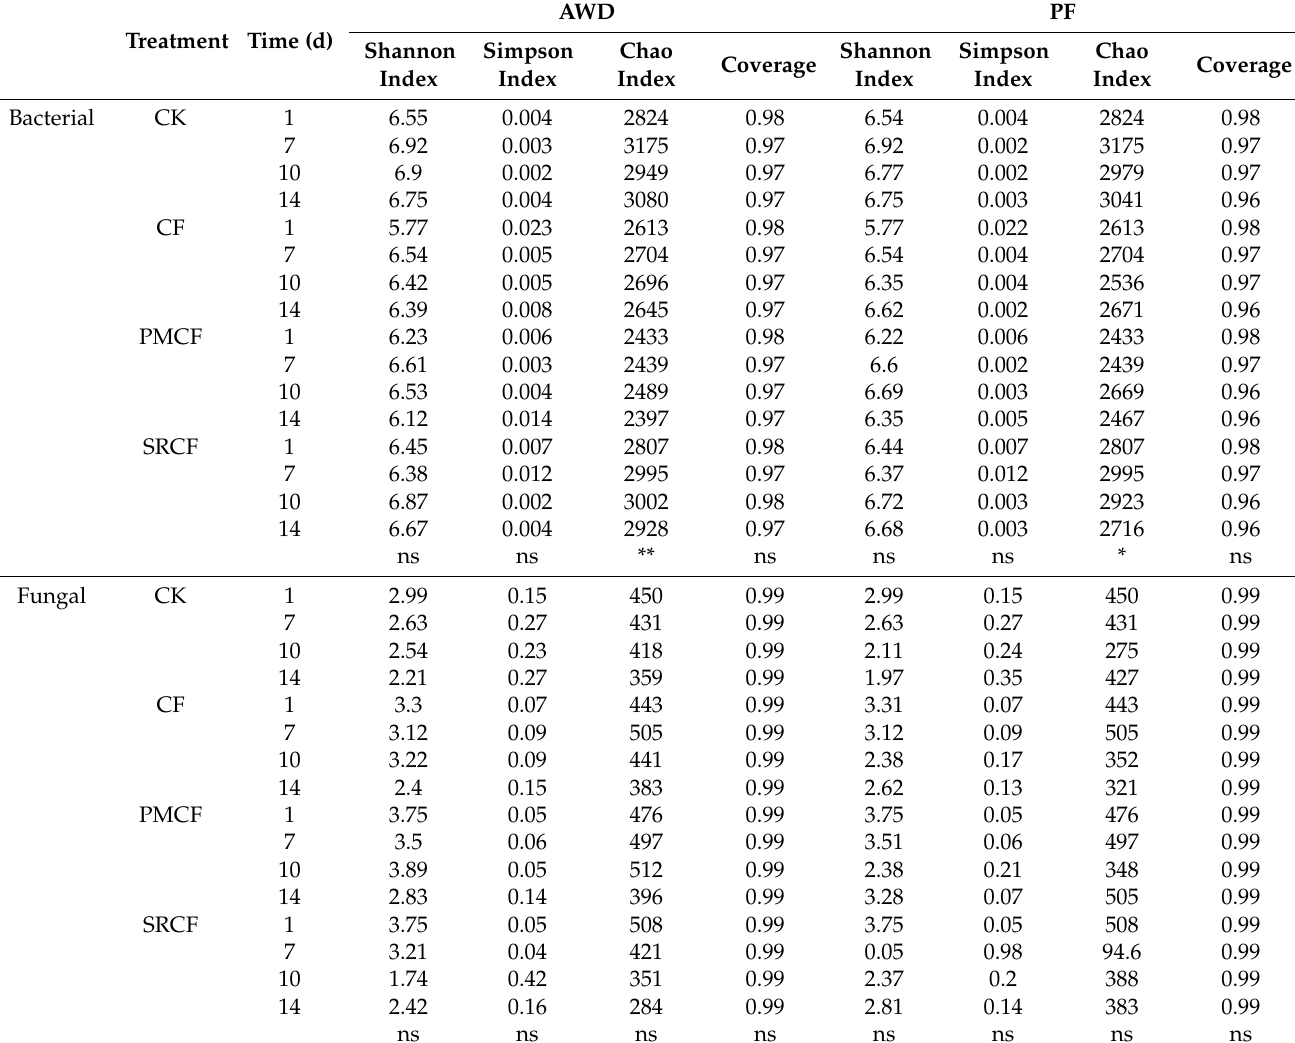
Table 2. Changes over time in α -biodiversity indices of nitrifying and denitrifying bacteria and fungi based on 16S rRNA gene in soils collected from long-term experiment plots of the unamended control (Control), chemical fertilizers (CF), pig manure plus chemical fertilizer (PMCF), and rice straw